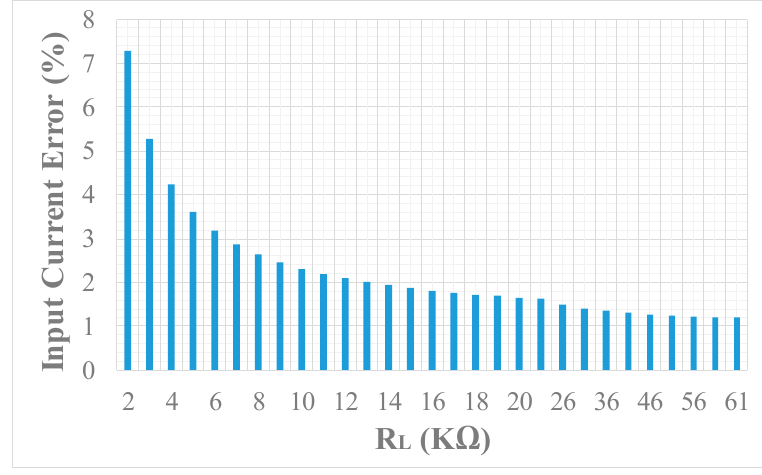
Figure 11. Input current error drawn by the source V in with varying R L load.